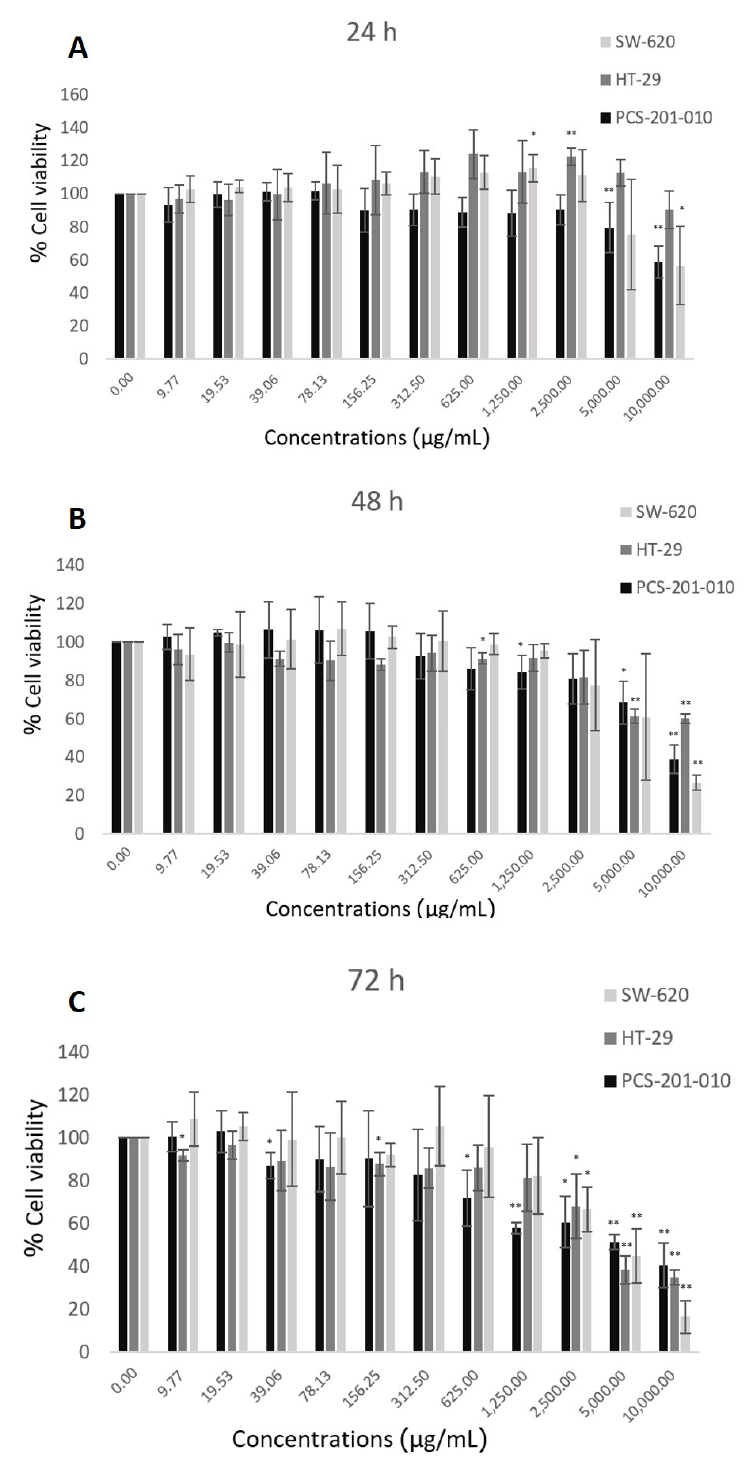
Figure 1. Cytotoxicity test by MTT assay on normal human fibroblast cell line (PCS-201-010), non- metastatic colon cancer cell line (HT-29) and metastatic colon cancer cell line (SW-620) after being treated with HRBE concentrations (0–10,000 µg/mL) for 24 h ( A ), 48 h ( B ) and 72 h ( C ). The untreated cells (0 mg/mL) were considered as negative control. The percentage of cell viability was determined as compared to an untreated condition. Data are represented by the mean ± SD. Statistical analysis was performed using one-way ANOVA (*, p ≤ 0. 05 significant; **, p ≤ 0. 01 significant ).